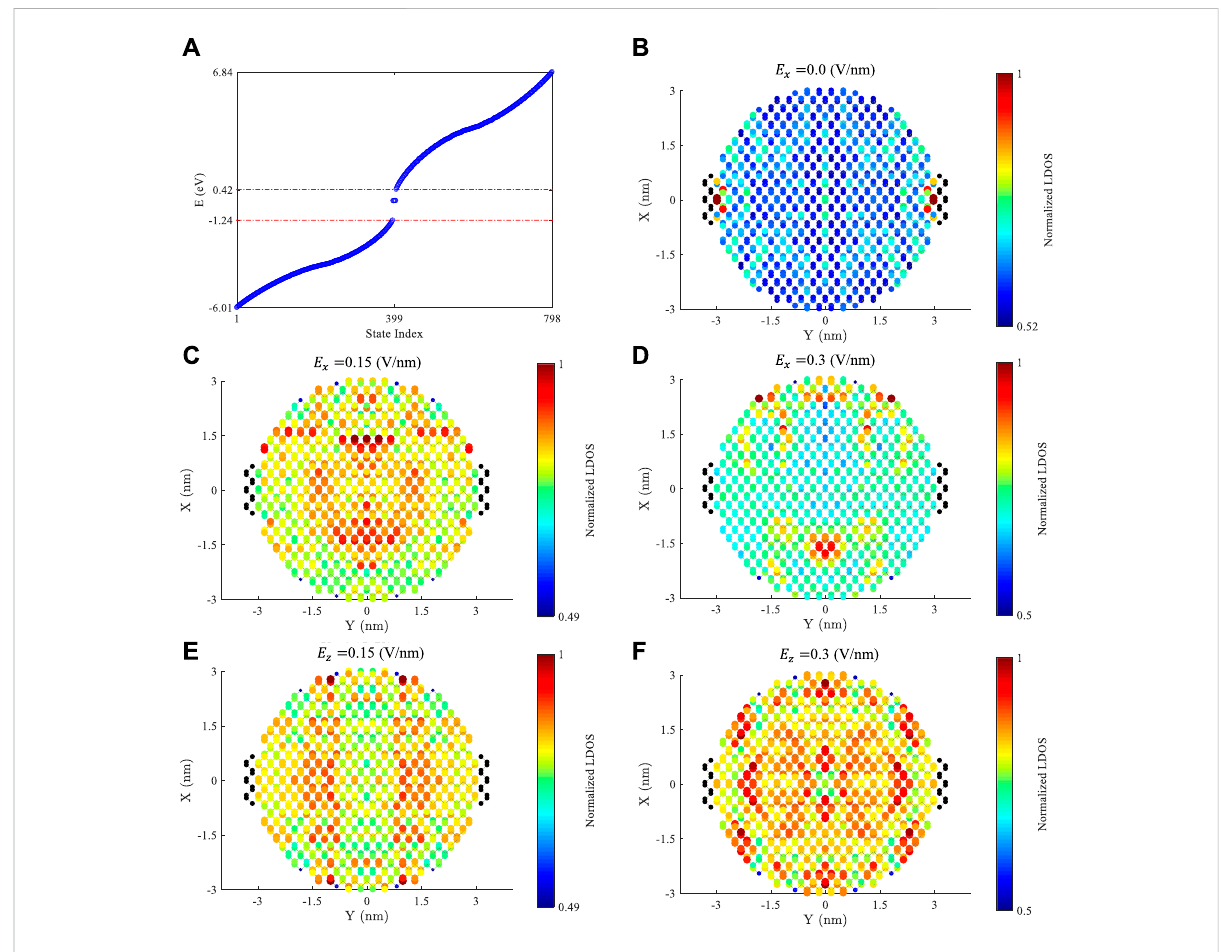
FIGURE 3 (A) Energy levels vs . state index for the PDisk. (B) Normalized LDOS for the PDisk in the absence of an electric fi eld, (C) E x (cid:2) 0.15 V/nm, (D) E x (cid:2) 0.3 V/nm, (E) E z (cid:2) 0.15 V/nm, and (F) E z (cid:2) 0.15 V/nm. Black dots indicate the closest unit cell atoms of the leads to the device. The gray lines are schematic of the bonding between the phosphorene atoms. The bonds between the leads and device are not